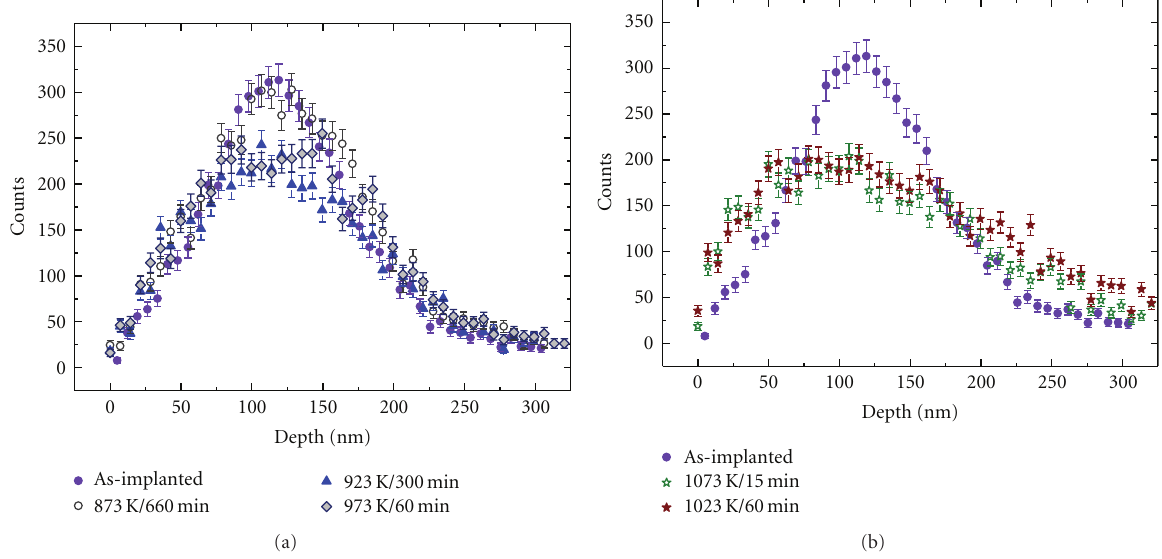
Figure 5: The broadening of the depth profile of implanted 30 Si determined by RNRA measurements at di ff erent annealing temperatures.